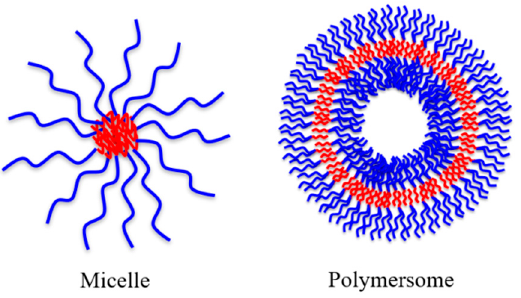
Figure 4. Aqueous self-assembly of AB 2 miktoarm polymers into micelles and polymersomes, depending on polymer hydrophilic fraction (red = hydrophobic, blue = hydrophilic).